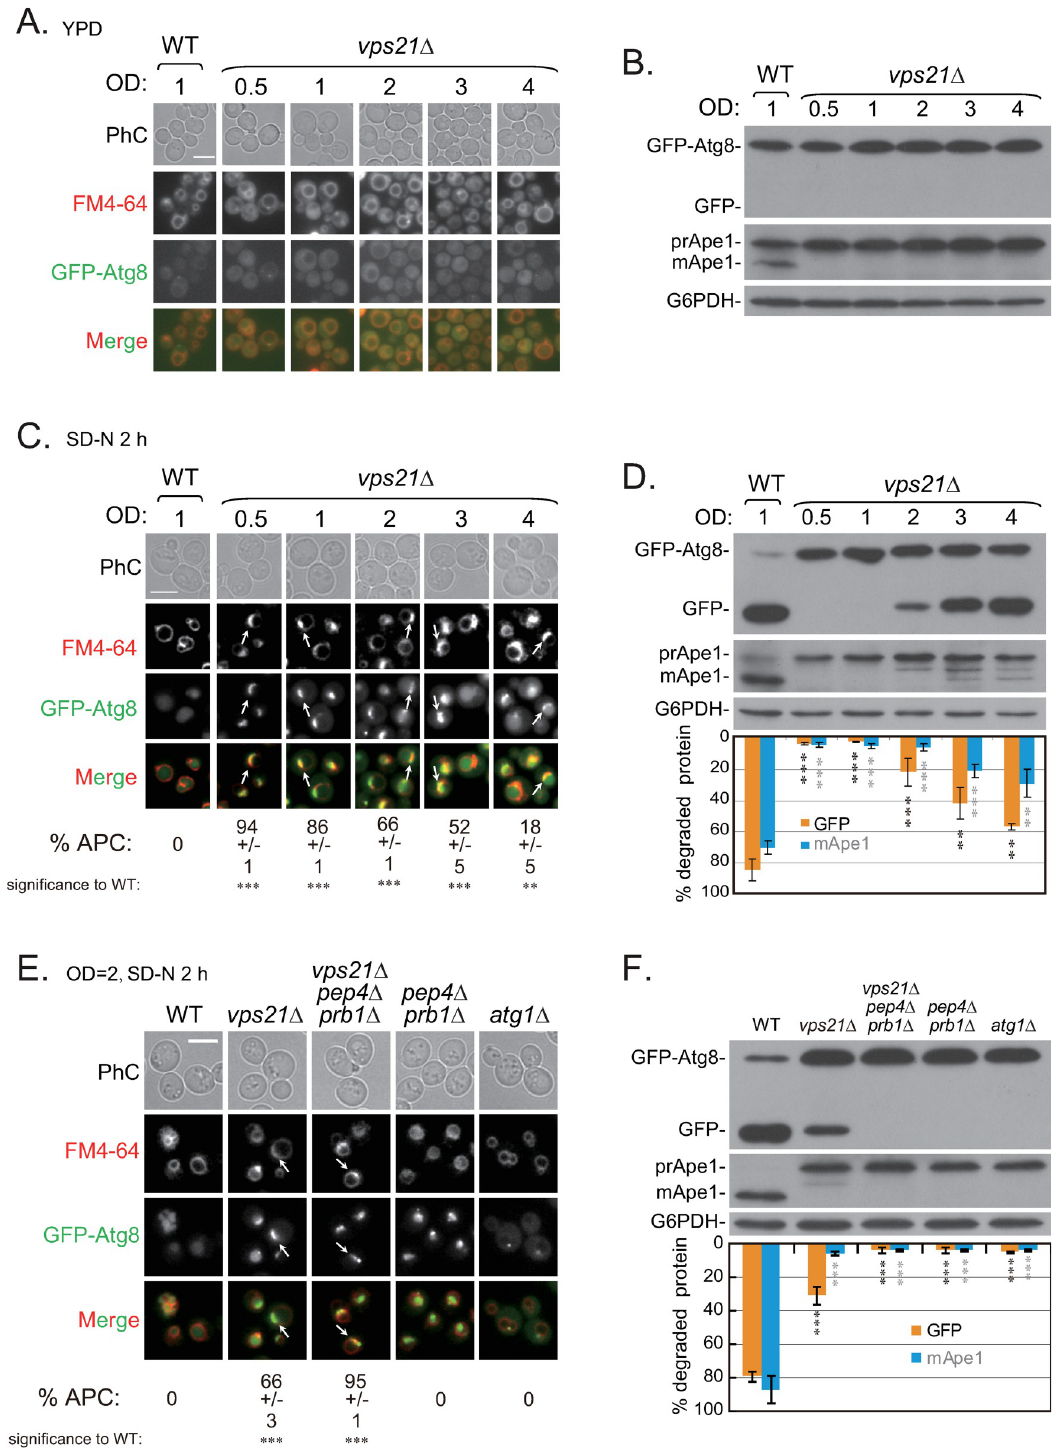
Fig 1. The growth stage before nitrogen starvation and the availability of vacuolar hydrolases impacted the accumulation of autophagosome clusters (APCs) in vps21 Δ cells. A. The increased cell density (OD 600 ) of vps21 Δ cells grown in rich medium did not result in GFP-Atg8 entering into vacuoles. GFP-Atg8-labeled WT and vps21 Δ cells were grown to the indicated OD 600 values in rich medium (yeast extract peptone dextrose [YPD] medium) and observed for GFP-Atg8 localization and FM4-64 signals. For WT cells, only the results at an OD 600 of 1 are presented. B. No autophagy processing was detected in vps21 Δ cells with OD 600 values